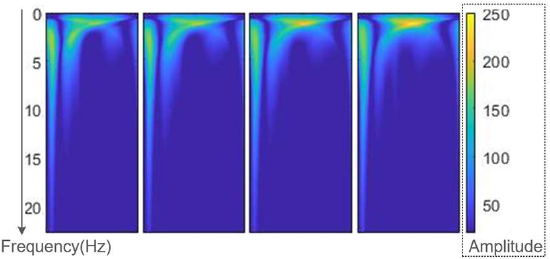
Figure 3. Time-frequency diagrams of four pulse waveforms.